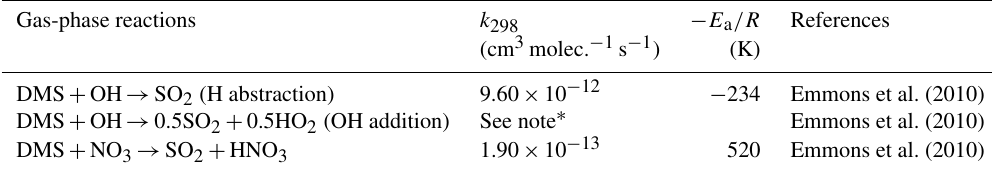
Table 3. The three DMS oxidation reactions in the standard CAM6-chem. Gas-phase